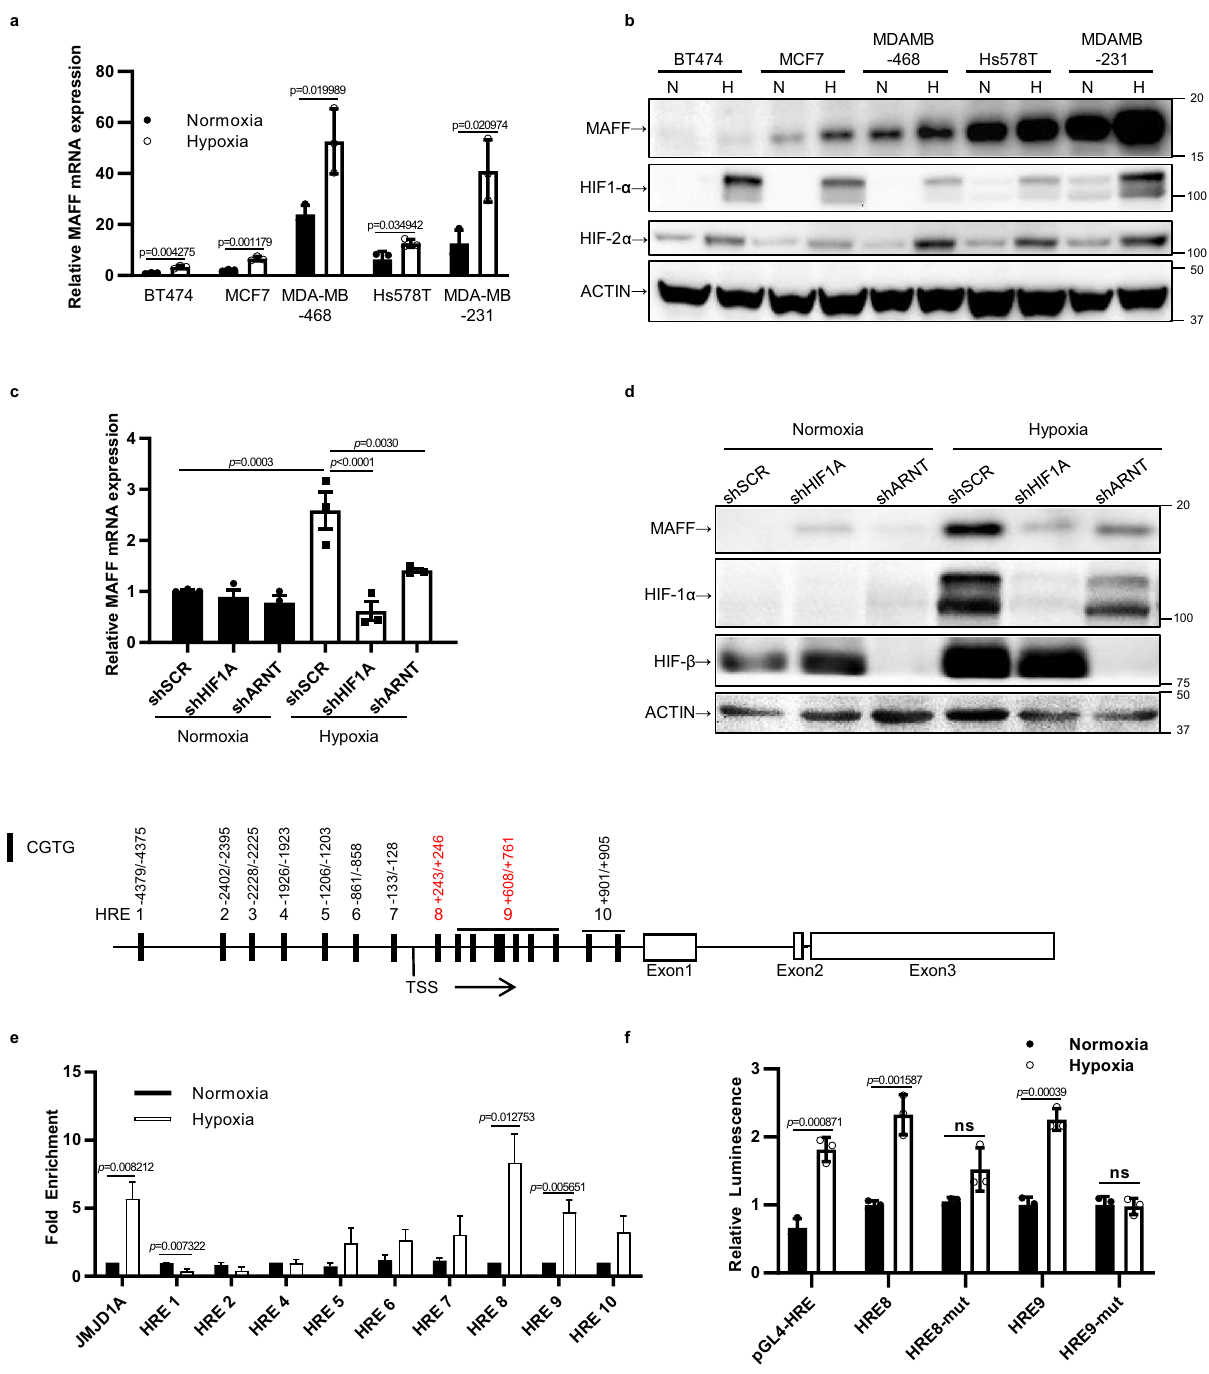
Fig. 2 MAFF induction under hypoxia is regulated by HIF-1. a MAFF mRNA expression was elevated under hypoxia in breast cancer cell lines. n = 3 biological replicates. Unpaired t -test. b While basal expression of MAFF was different, hypoxia increased MAFF expression in all breast cancer cell lines. c , d Knocking down HIF1A or ARNT (HIF β ) prevented MAFF mRNA and protein induction under hypoxia. One-Way ANOVA with multiple comparisons. e ChIP assay was performed to identify a HIF-1 binding site on the MAFF promoter (HRE8 and 9) (TSS: transcription start site). n = 4 biological replicates. Unpaired t -test. f Luciferase reporter assays showed that transcription activity of HRE8 or HRE9 was increased under hypoxia compared to mutated HRE8 or HRE9. pGL4-HRE, which contains 4x HRE regions, was used as a positive control. n = 3 biological replicates. Unpaired t -test. Graphs represent the mean per group and error bars represent the SEM. ns: not signi fi Genome-wide analysis of MAFF-mediated gene regulation by hypoxia for 24 hours, with or without genetic inhibition of MAFF RNA- and ChIP-sequencing . To identify genome-wide down- by siRNA. When MAFF was inhibited under normoxia, 415 genes stream targets of MAFF in tumor cells that are involved in tumor were identi fi ed to be signi fi cantly changed, while hypoxia altered invasion and metastasis, we performed high throughput RNA- 240 genes. Among these genes, 106 genes were regulated both sequencing of MDA-MB-231 cells exposed to normoxia or under normoxia and hypoxia. To obtain a global overview of the